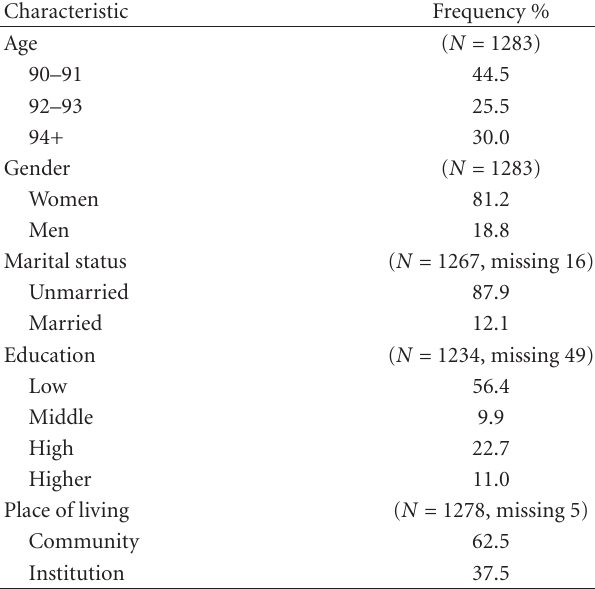
Table 1: Population